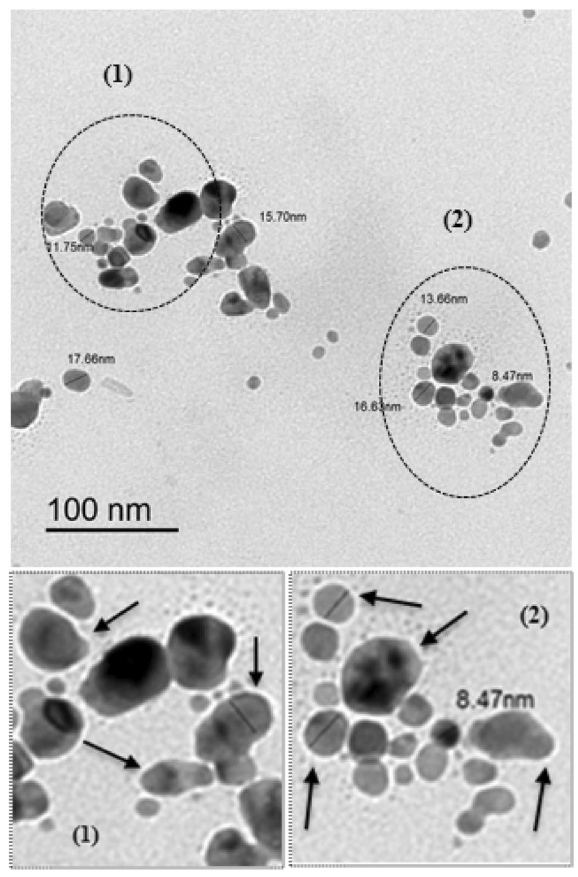
Figure 3. TEM image of fabricated Oscillatoria gelatin capped silver nanoparticles at 1 h with size in the range 8.47–17.66